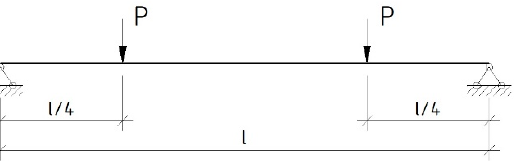
Figure 2. Continuous beam loaded with point load in the middle of each span. Damaged structure— middle support removed.